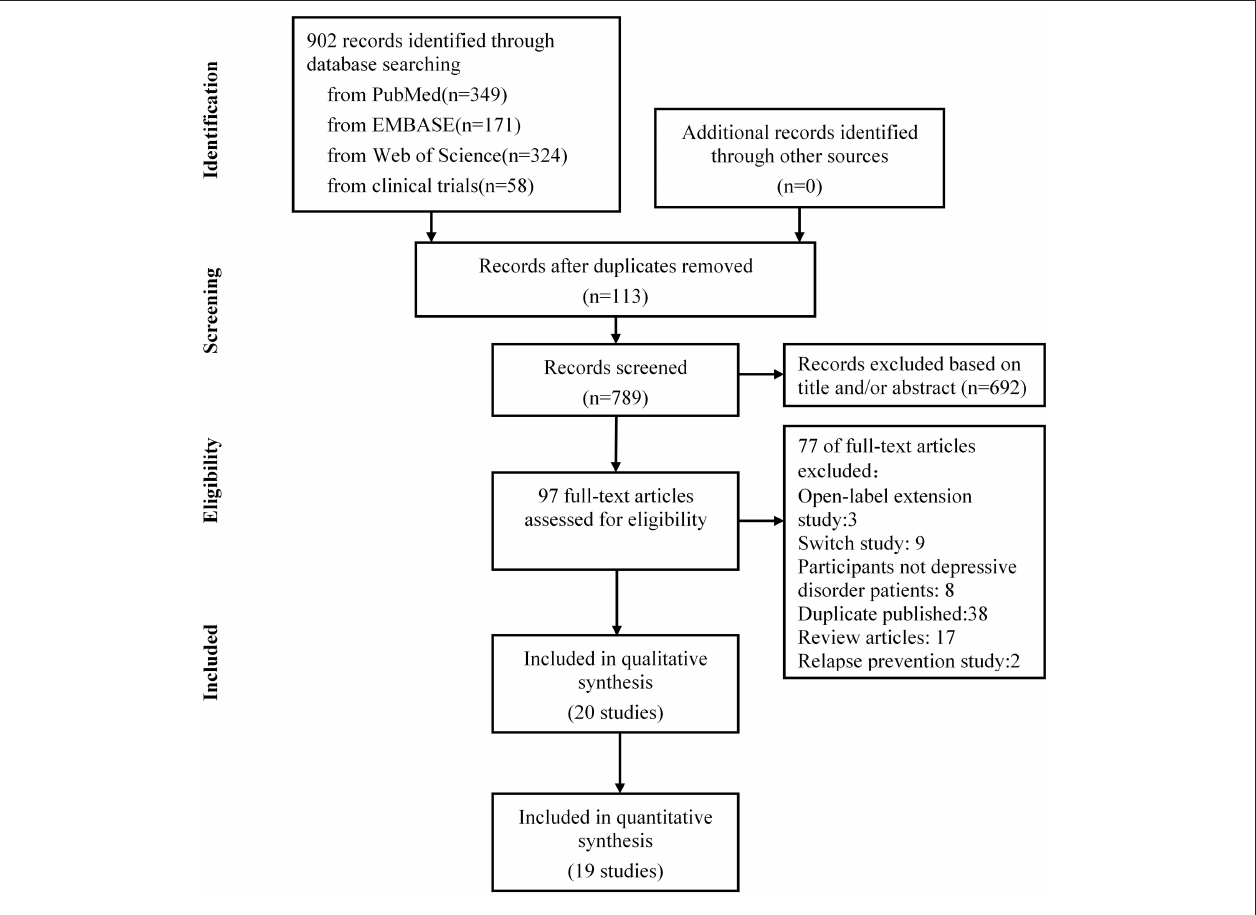
FIGURE 1 | Flowchart of the selection of the clinical